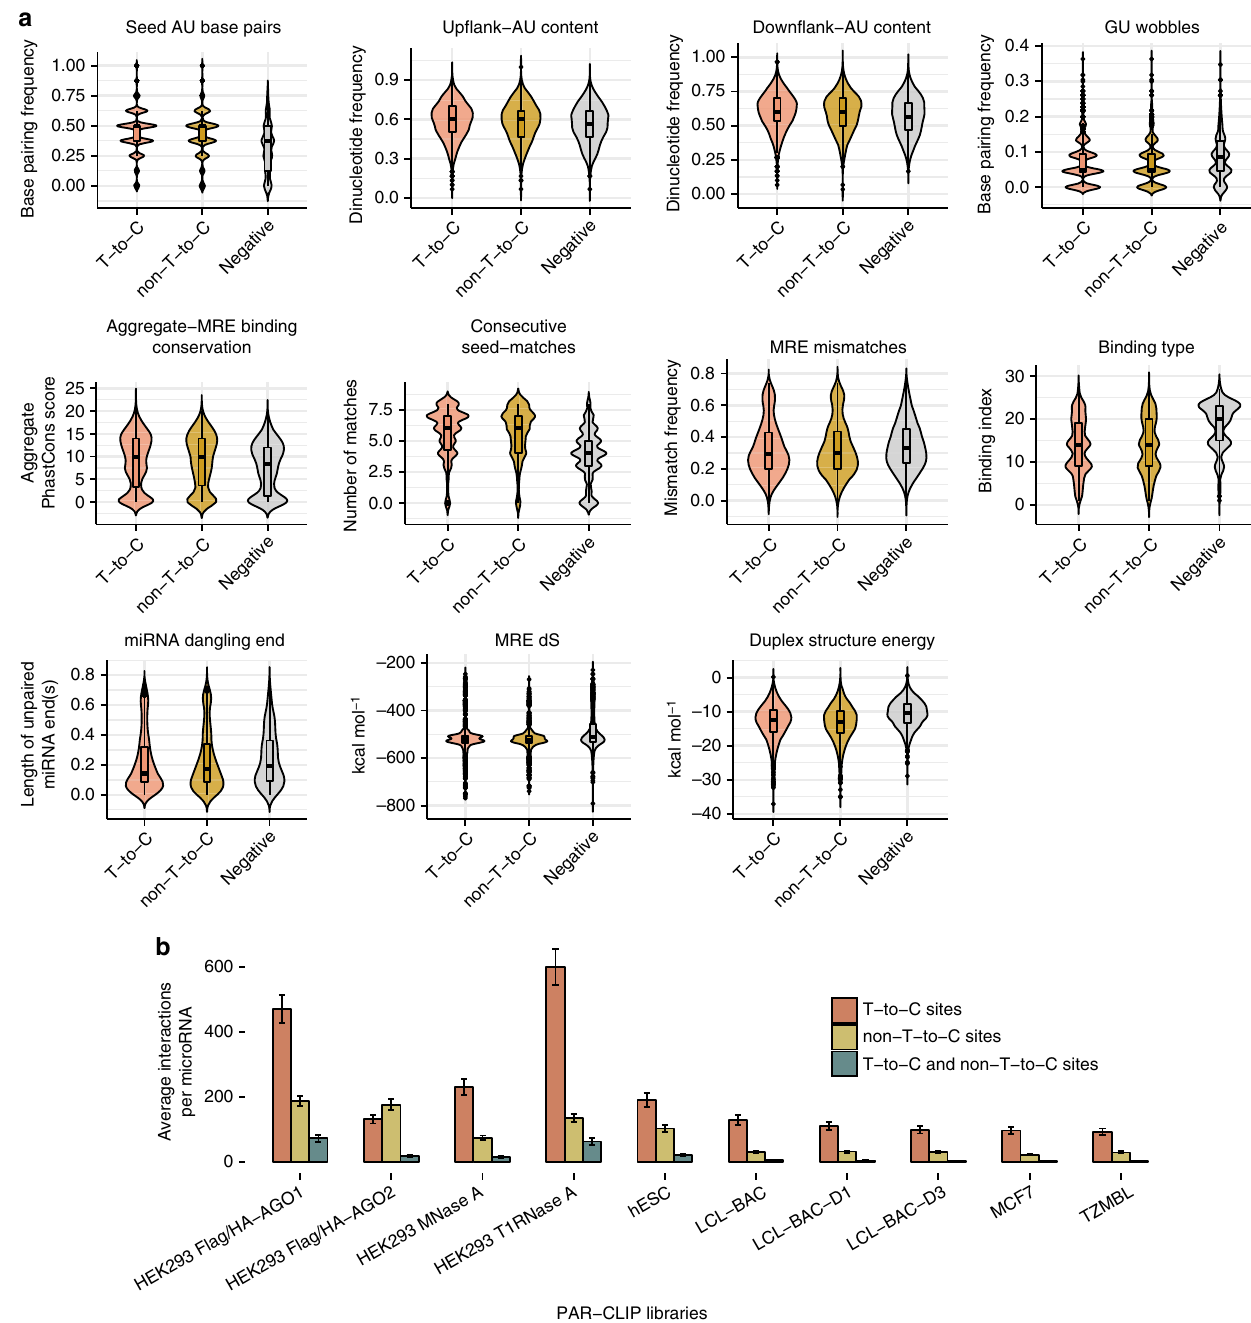
Fig. 3 Downstream evaluations of miRNA-binding sites identi fi ed on AGO-PAR-CLIP datasets. a Distributions of MRE-related features corresponding to positive miRNA interactions in T-to-C and non-T-to-C AGO-bound regions against the relevant densities of negative binding sites. Evaluated descriptors include AU seed base pairs, AU fl anking content, GU wobble pairs, MRE conservation, consecutive matches and mismatches per miRNA-target duplex domain, and binding type. The latter feature comprises an extended set of (non-)canonical miRNA base pairings where smaller values indicate stronger seed matches (9mer to 6mer) and greater values correspond to noncanonical and 3 ′ supplementary sites. Distributions of miRNA-end nucleotides not participating in the hybrid (miRNA dangling end), MRE-related thermodynamic properties of entropy (dS) and minimum free energy are also evaluated. Assessed characteristics of positive miRNA interactions on (non-)T-to-C clusters signi fi cantly diverge from respective feature distributions of negative MREs (two-tailed Wilcoxon rank-sum test). b Bar plots featuring the average miRNA-target interactions supported by non-T-to-C and/or T-to-C peaks per examined cell type and experimental condition. Mean and standard errors (error bars) of miRNA interactions are shown per library. An average increase of 14% (±8.8%) in the detected interactions was observed across analyzed PAR-CLIP libraries by the incorporation of non-T-to-C